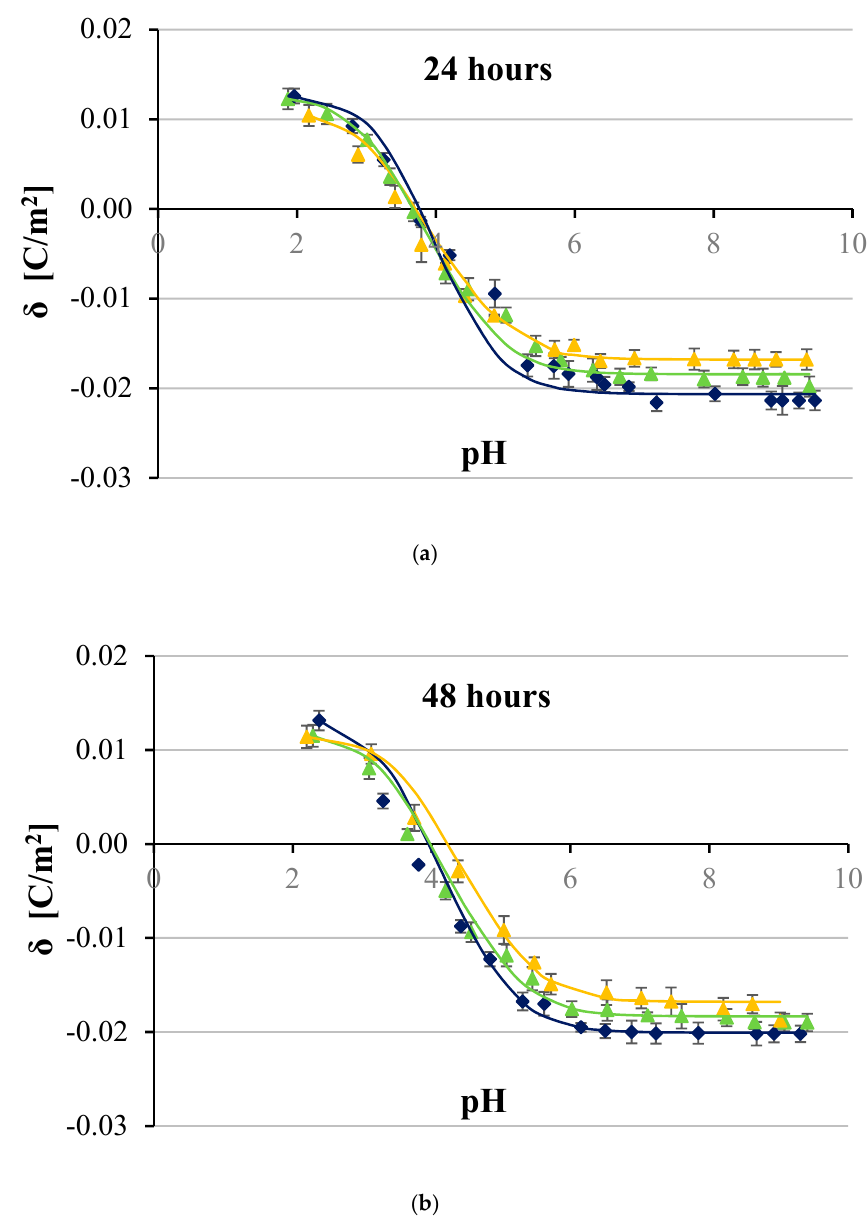
Figure 4. Dependence of surface charge density of glioblastoma LBC3 cell line as a function of the pH of the electrolyte solution. The cells were untreated (navy blue) or treated with 5 (green) and 8 (orange) mmol / dm 3 of p-coumaric acid for 24 h ( a ) and 48 h ( b ). Solid lines describe theoretical values; experimental data are marked by points.